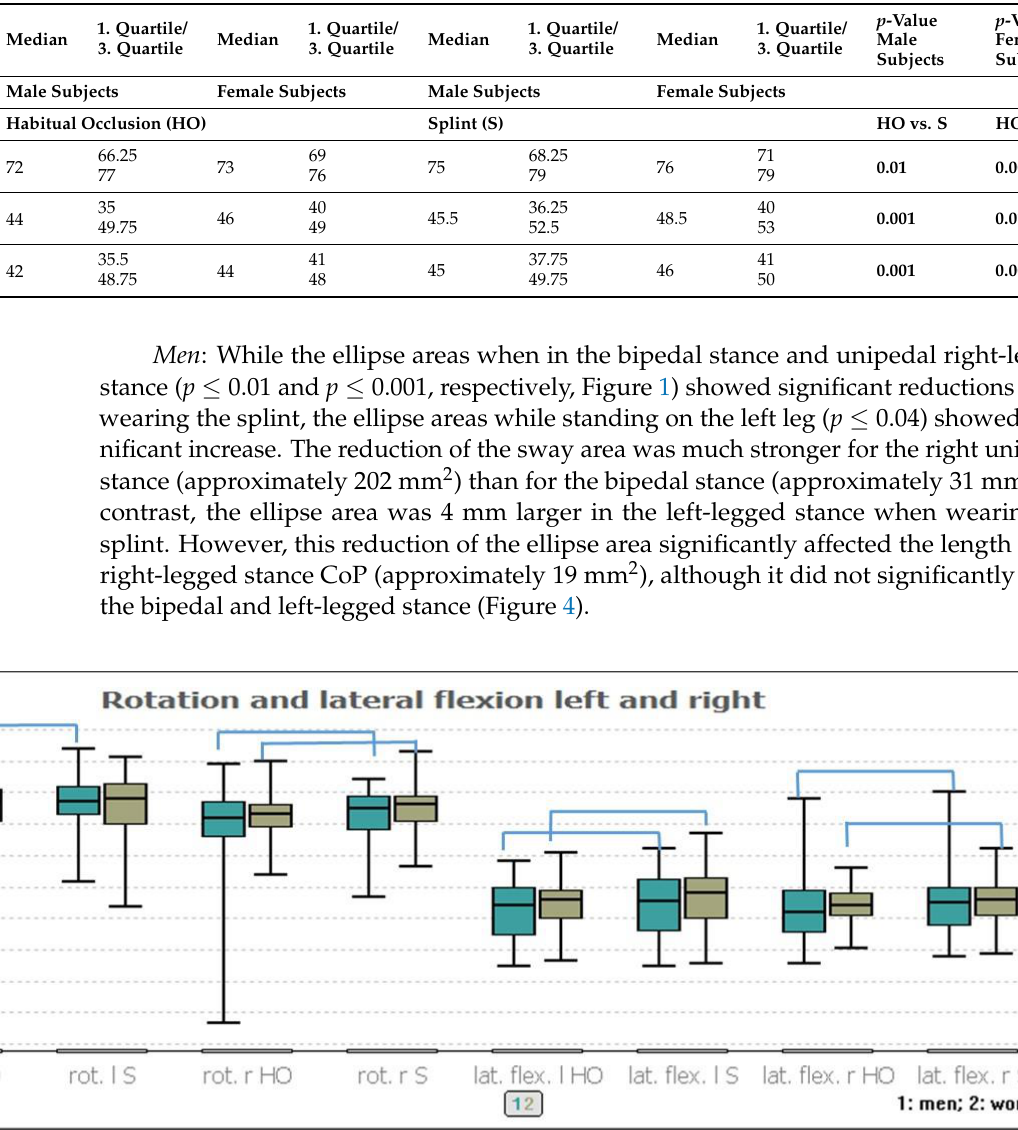
Table 3. Differences between habitual occlusion and splint (median, 1st and 3rd quartiles) of all parameters for men and women as well as the p -value of the comparison between the men and women. Significant p -values are marked in bold following Bonferroni-Holm correction.